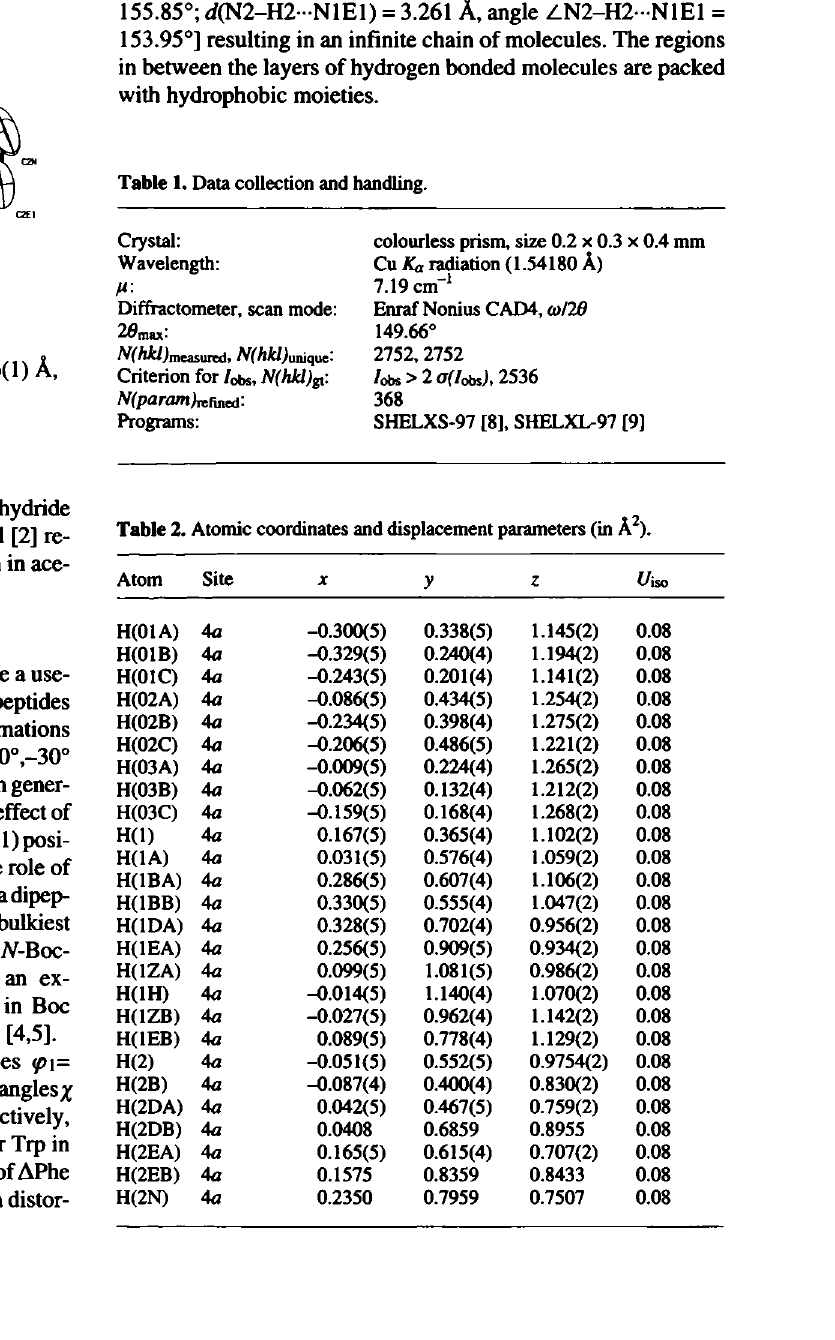
Table 1. Data collection and handling.